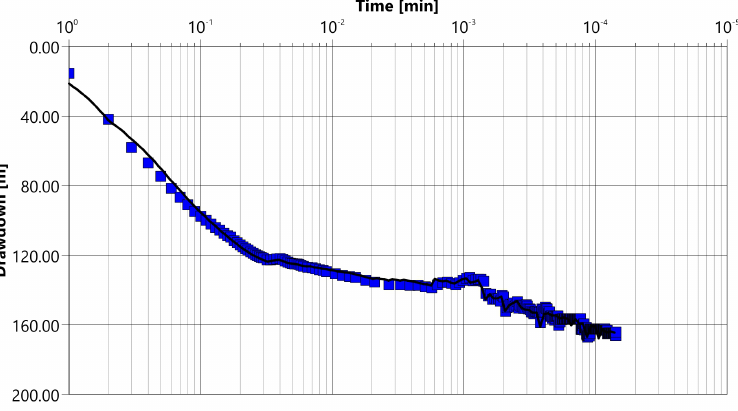
Figure 8. Analytical diagram for measurements in W-1 well during the first step of the pumping test (Agarwal’s method).